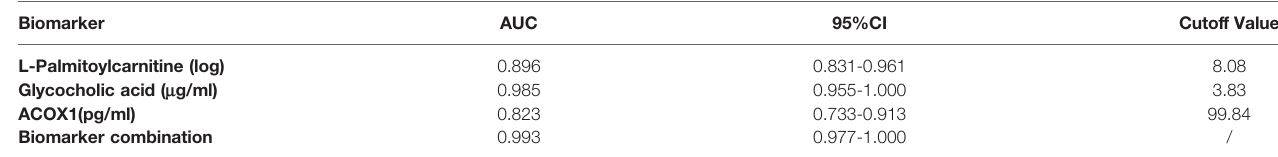
TABLE 4 | Diagnostic utility of serum biomarker levels among pregnant women with ICP in the third trimester. Biomarker